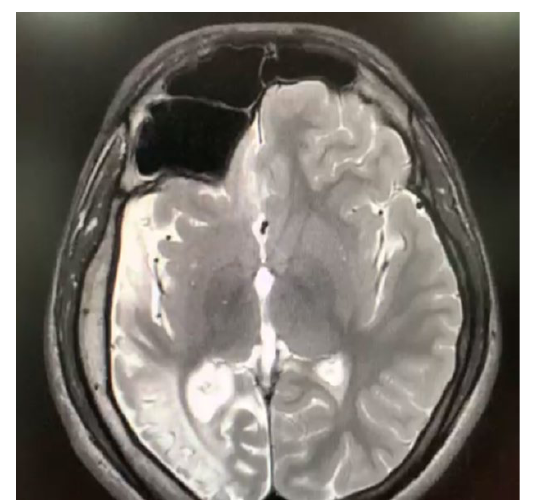
Figure 2 . MRI Showing Enlargement of Frontal and Hemisphenoid Sinuses on the Right Side with Elevation of the Right Petrous